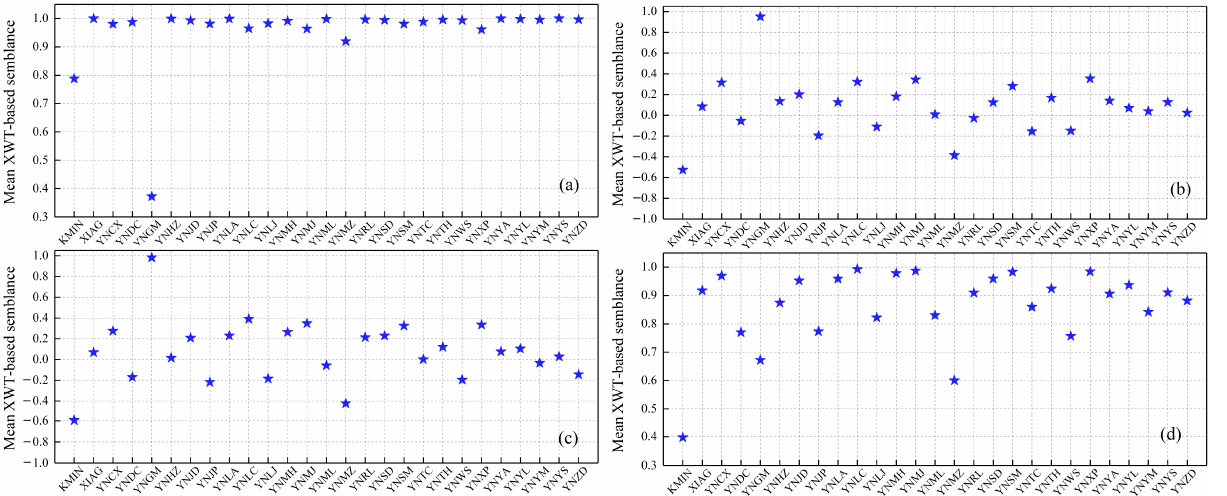
Figure 11. The mean XWT-based semblance between GPS and HYDL ( a ), ATML ( b ), NTOL ( c ), and their combined ( d ) time series for all stations at the period closet to 1 year.